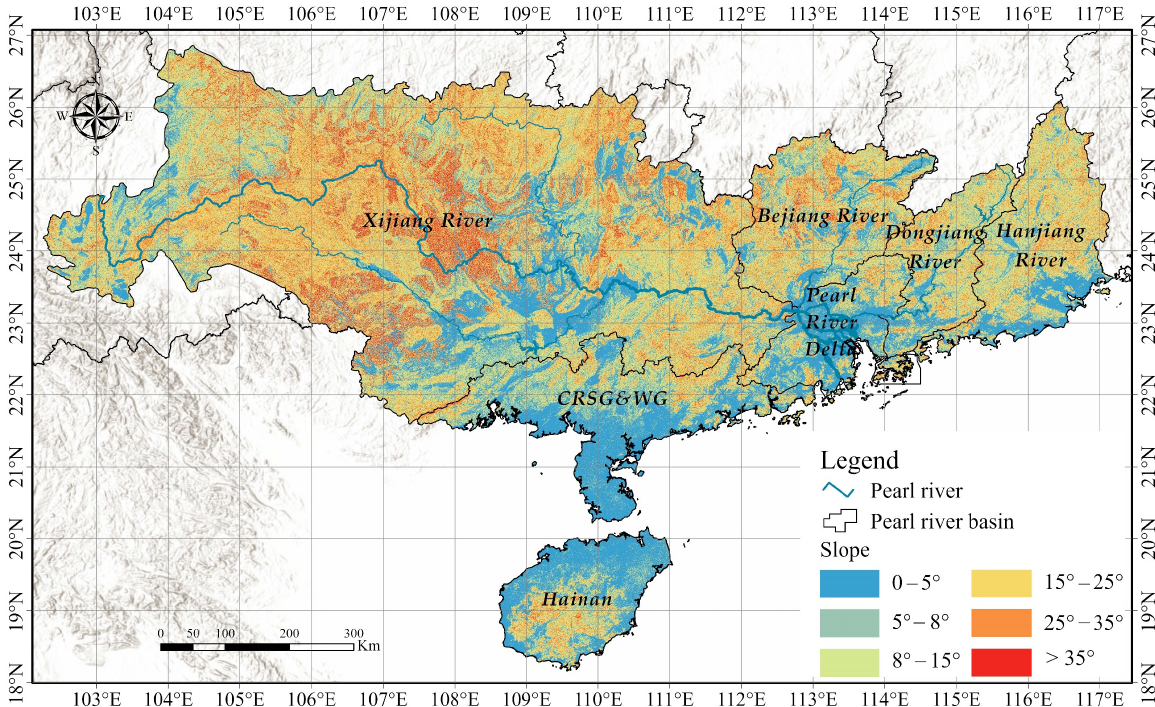
Figure 1. Location of the Grand Pearl River Basin.